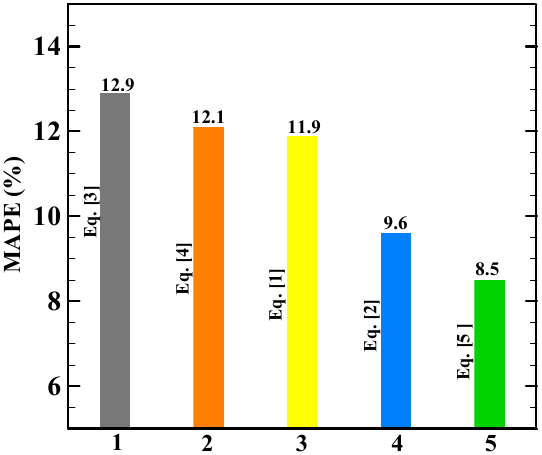
Figure 8. Normalized turbulent burning velocities of iso-octane/air mixtures using Equation (5). Here we apply Equation (6) to estimate MAPE and the results are shown in Figure 9. MAPE is a better statistical variable than the goodness R 2 , because the latter depends strongly on the available data volume to estimate the uncertainty of these five general correlations (Equations (1)–(5)). Note that the lower the MAPE is, the more accuracy of the correlation is. All MAPE percentages for the aforesaid five general correlations are less than 13%, showing that these general correlations are reasonably good. Among them, the best is Equation (5) proposed by Ritzinger [20] with a lowest MAPE of 8.5% and the second best is Equation (2) proposed by Kobayashi et al. [8,19] with a MAPE of 9.6%. The other three general correlations (Equations (1), (3), (4)) have roughly the same MAPE (11.9%–12.9%). It should be noted that Equation (2) is probably the most convenient one to use, because it does not require any length scales of turbulence and flame. Energies 2019 , 12 FOR PEER REVIEW Figure 9. The accuracy of five general correlations determined through the use of mean absolute. We now discuss the iso-octane comparison between the present data and previous data obtained by Lawes et al. [17] using Equation (4). The comparison results are presented in Figure 10. The main reason that we use Equation (4) for comparison is because the Damköhl er number ( Da ) to the one half power has been extensively used by Peters [31]. Besides, Da = ( L I / u ′ )( S L / δ L ) includes the important integral length scale of turbulence ( L I ), but Equation (2) and Equation (3) do not include L I . A good agreement between present and previous data is found. Both present and previous iso-octane S T, 𝑐̅ =0.5 data can be represented by a scaling relation of S T, 𝑐̅ =0.5 / u ′ = 0.082 ( DaLe –1 ) 0.5 with a reasonable goodness of R 2 = 0.78.